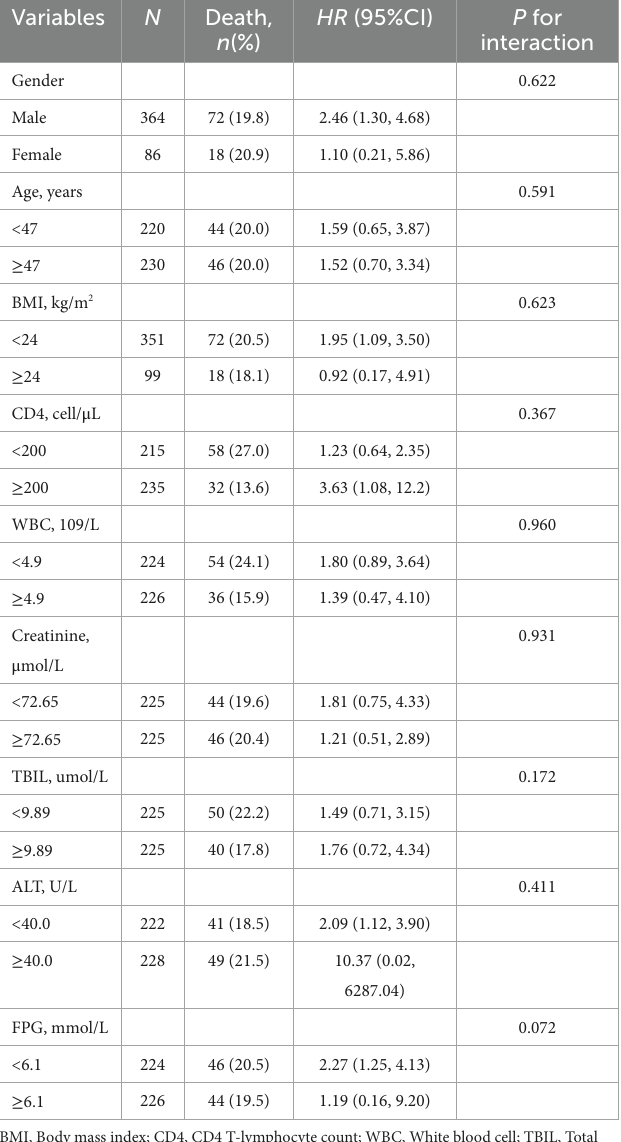
TABLE 3 Subgroup analyses on the association of anemia with the mortality of PLWHA.